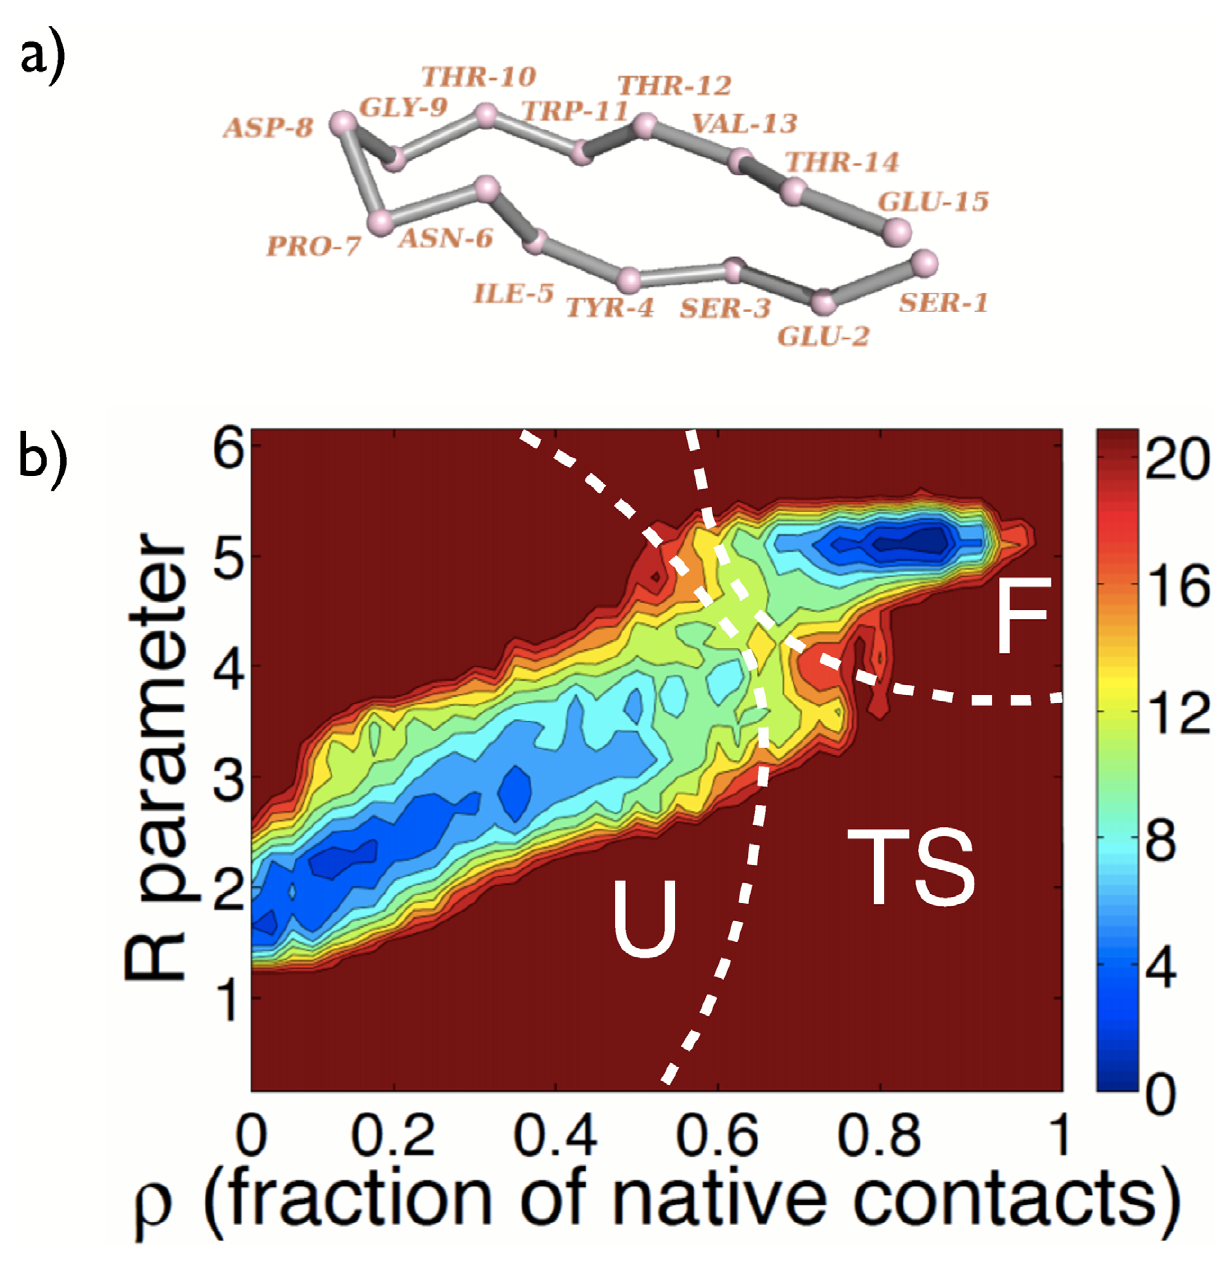
Figure 1. Snapshot of Peptide 1 and contour map of the free energy change. a) Backbone snapshot of Peptide 1 extracted at the end of the simulation started from the NMR structure. For clarity only the C a atoms are shown. b) Contour map of the free energy change, D A, as a function of the position in the r -R plane (fraction of native contacts, r , within the peptide - R parameter). D A is calculated with respect to the state with the highest probability, i.e., the b -hairpin state. Three distinct states can be identified. The states with the two deep minima are the unfolded (U) and folded (F) states and the saddle point corresponds to the single transition state (TS), i.e., the barrier that all molecules must cross if they are to fold to the native state. The F, U and TS states were defined as follows: F comprises all structures populating the basin around the global minimum at r =0.85 and R=4.95, and with free energy values within 12 kJ/mol from the global minimum; U comprises all structures populating the basin around the local minimum at r =0.10 and R=2.10, and also with free energy values up to 12 kJ/mol; the structures at the top of the barrier, i.e., not belonging to F or U, were assigned to the TS. state ( D A & 2 kJ/mol). After about 5–10 m s of sampling for all grid cells, the values are rather stable (within 1–2 kJ/mol). Figure 2b shows the probability distribution of the free energy standard deviations, s D A (see Methods section for the estimate of the errors), for all the grid cells. Again, these show relatively small statistical errors in the free energy values (again within 2 kJ/mol).